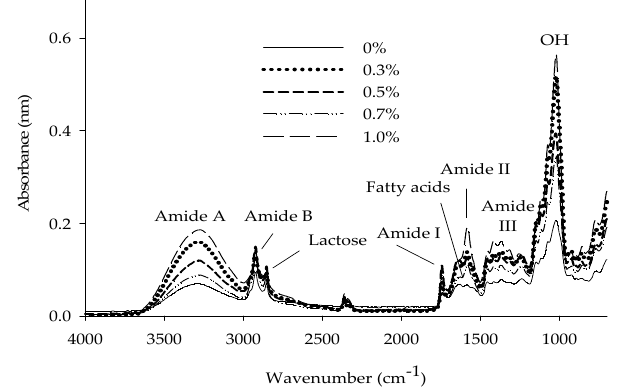
Figure 2. Fourier transform-infrared spectra of the functional whey beverage with different concentrations of hydrolyzed collagen.